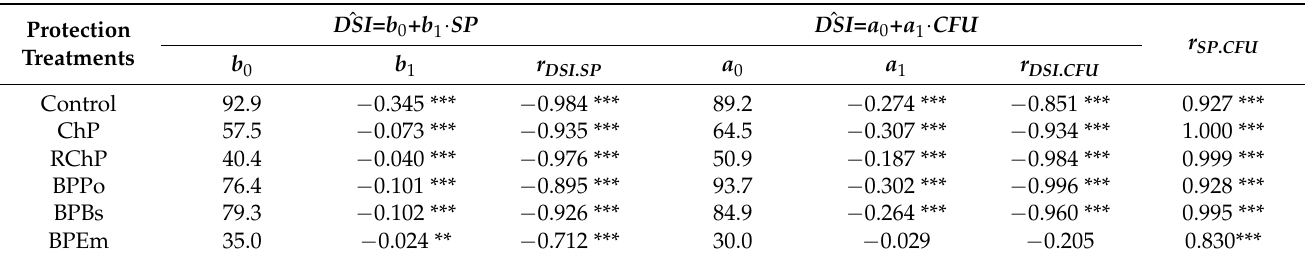
DSI in the plots where seedlings were treated with E. maxi ma extract and the control plot. Table 3. Relationships between the intensity of Verticillium wilt of horseradish roots (DSI) and the number of colony forming units (CFUs) and between the intensity of Verticillium wilt of horseradish roots (DSI) and the sum of precipitation in the growing season (SP) and CFUs and the sum of precipitation in the growing season.